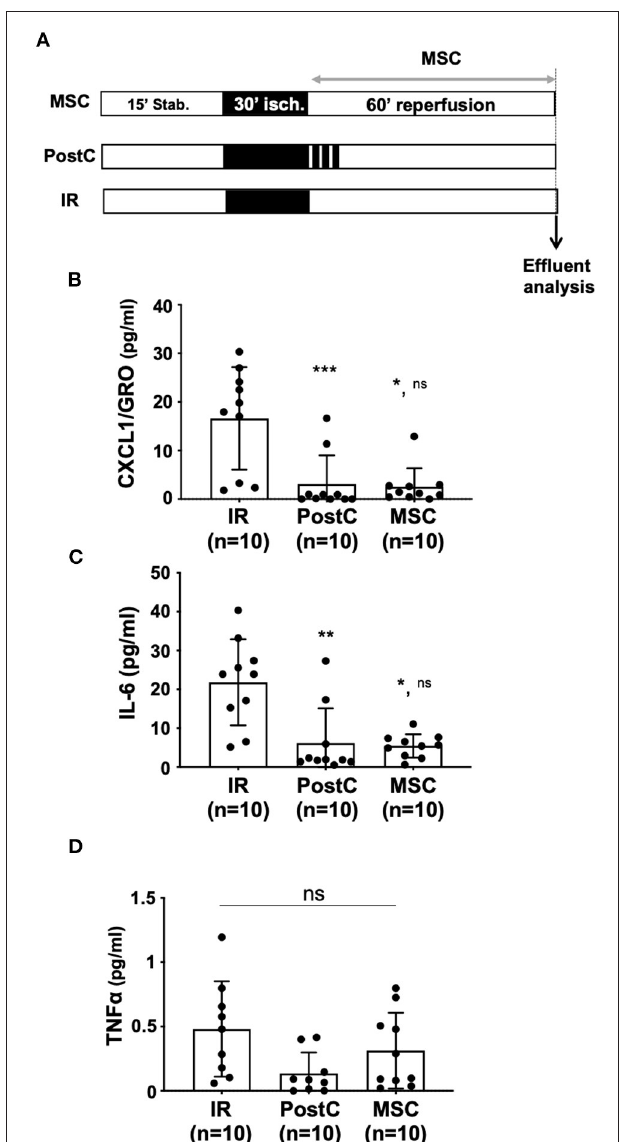
FIGURE 3 | (A) Isolated hearts perfused ex vivo on the Langendorff system were submitted to the perfusion protocol similar to that described in Figure 1A . In the MSC group, reperfusion was achieved with a MSC Tyrode solution (5,000 cells/ml). For the PostC group, a postconditioning stimulus comprising three cycles of 1min ischemia-1min reperfusion was applied at the onset of reperfusion. In the control condition (IR), hearts were reperfused with Tyrode solution alone (control condition). Coronary effluents were collected at the end of the reperfusion phase to evaluate cytokine production after IR, PostC or MSC protocols. (B–D) Scatter plots with bars (mean ± SD) are presented for quantification of cytokines within coronary effluents collected after 60min of reperfusion using the Meso Scale Discovery (MSD) V-Plex Plus Proinflammatory Panel 1 (mouse) kit. Statistical analysis was performed using the Kruskal-Wallis test followed by the Dunn’s post test. (B) For CXCL1 (pg/mL), *** was noted for p = 0.0006 (PostC vs. IR), ** for p = 0.018 (MSC vs. IR) and ns for p > 0.999 (MSC vs. PostC). (C) For IL-6 (pg/ml), ** was noted for p = 0.0021 (PostC vs. IR), * for p = 0.0287 (MSC vs. IR) and ns for p > 0.999 (MSC vs. PostC) and (D) : for TNF α (pg/ml), ns was noted for p =